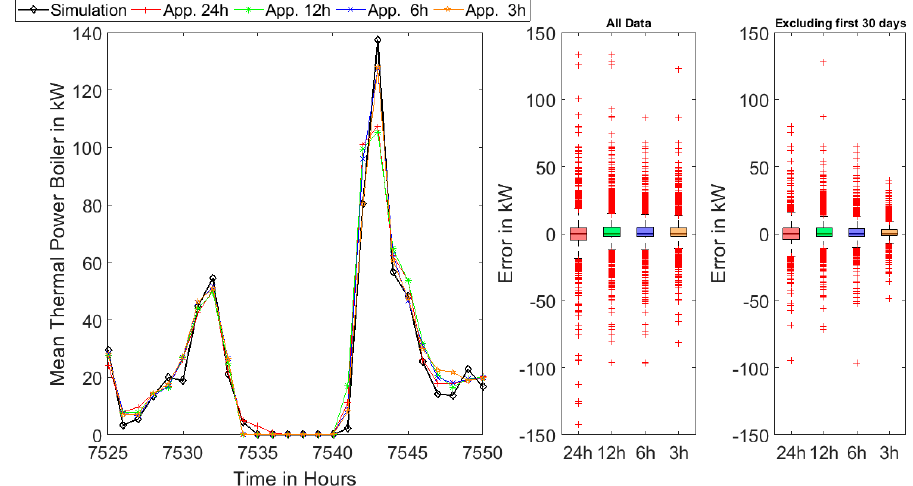
Figure 9. Left: Exemplary course of the boiler power prediction for one day based on different